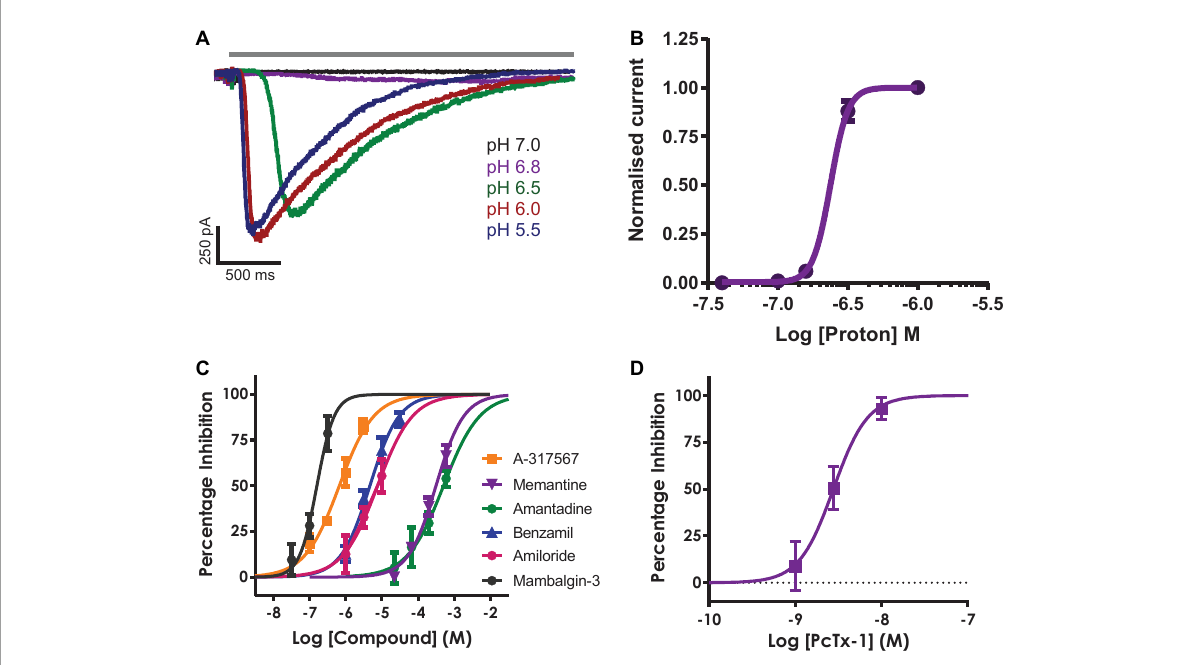
FIGURE6 Pharmacology of hASIC1a responses in CHO cell line on QPatch 48. (A) Current traces in response to application of solutions (solid gray bar) with indicated acidity. (B) pH activation curve indicates an EC 50 of 6.62 (mean ± S.D, n = 5). (C) Concentration-response curves for indicated